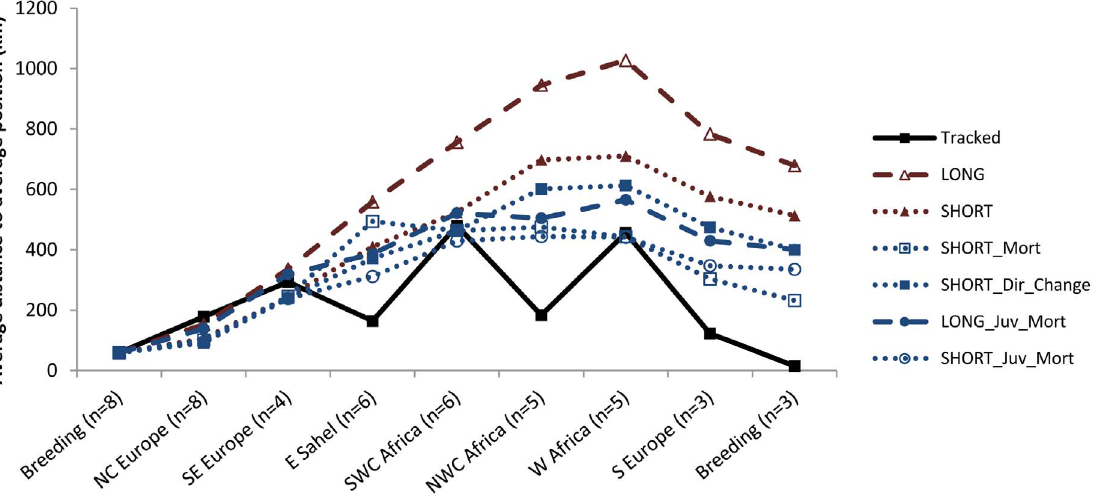
Figure 3. Distances among individual common cuckoos on tracked (solid line) and simulated stopovers during the whole annual migration (see Table 1 for explanation of the types of simulations). In the tracked birds, the values represent average distance from the birds to the average position at that stopover. For the simulated birds, the values are averages of 10,000 bootstraps of average distance from the birds to the average position in that specific stopover. In NC Europe and SE Europe no simulations were significantly different from the tracked birds. In E Sahel, NWC Africa, S Europe and Breeding all simulations were significantly more scattered than the tracked birds. In SWC Africa and W Africa only LONG was significantly more scattered than the tracked individuals (statistical comparisons based on bootstraps in Table S2).